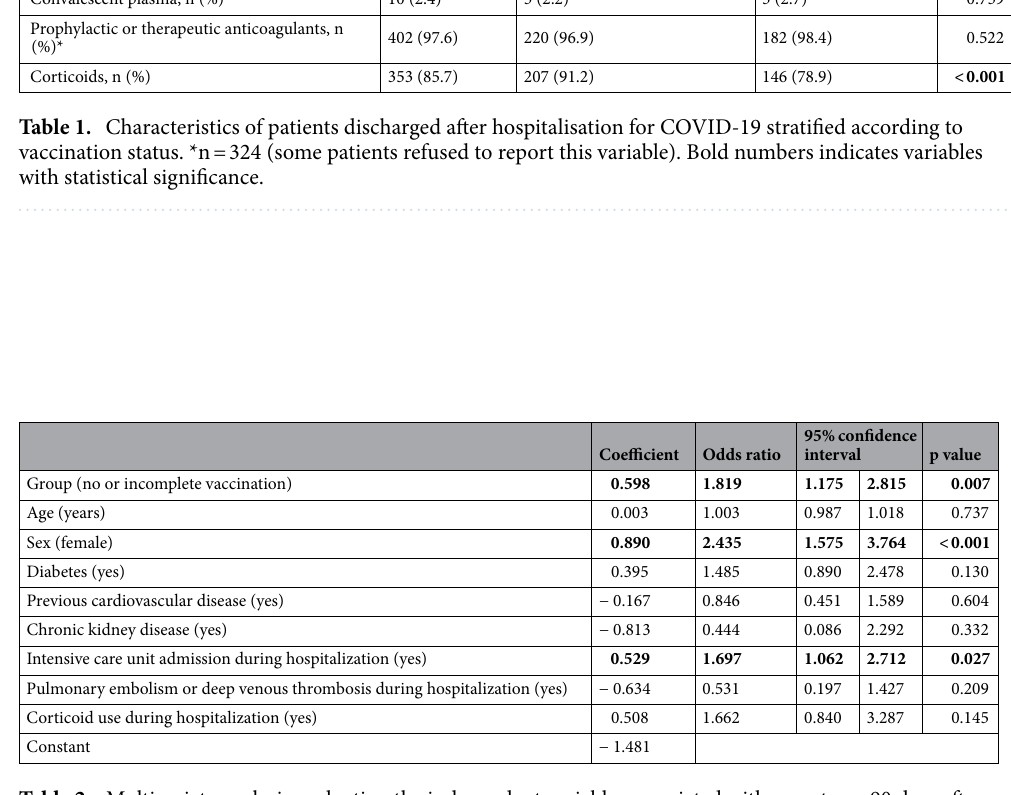
Table 2. Multivariate analysis evaluating the independent variables associated with symptoms 90 days after hospitalization due to COVID-19. Bold numbers indicates variables with statistical